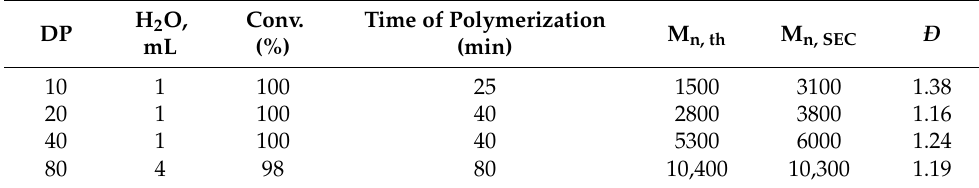
Figure 3. The evolution of molecular weights of PDEA (DP = 10–80) catalyzed by the generated Cu(0) particles/CuBr 2 /Me 6 TREN complex in water determined by GPC using DMF as the mobile phase.